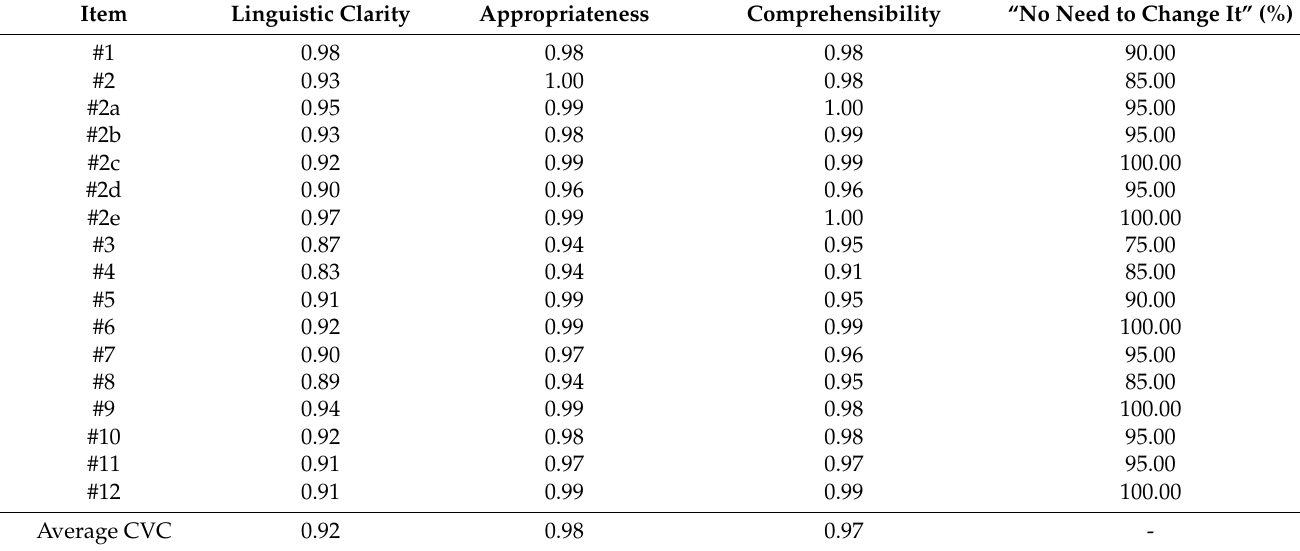
Table 4. CVC of the 2nd version of the SFLQ-Br by the general population.